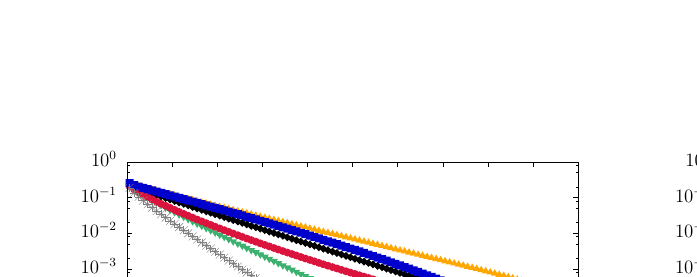
Figure 3: Ensemble-averaged spatial flux (cid:104) ϕ ( x ) (cid:105) , in a box of size L densities τ ( x ) . Green inverted triangles correspond to law a, black diamonds to law b and orange triangles to law c. Red circles correspond to law d (top), law f (center) and to law h (bottom). Blue circles correspond to law e (top), law g (center) and law i (bottom). Left. Σ β = 1 . Right. Σ β = 10 . For comparison, grey stars represent the atomic mix s s